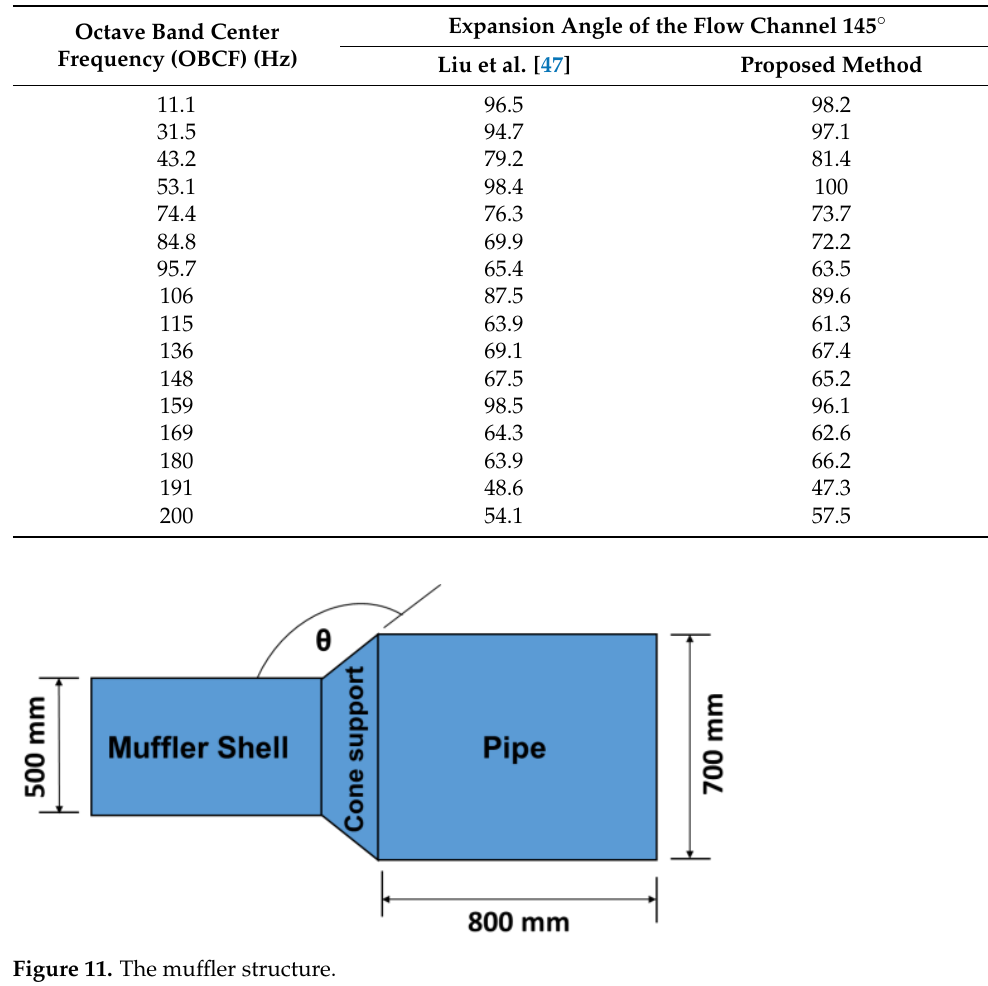
Table 3. The peak transmission loss (TL) of the muffler expansion angle of the flow channel 145 ◦ along the frequency range.